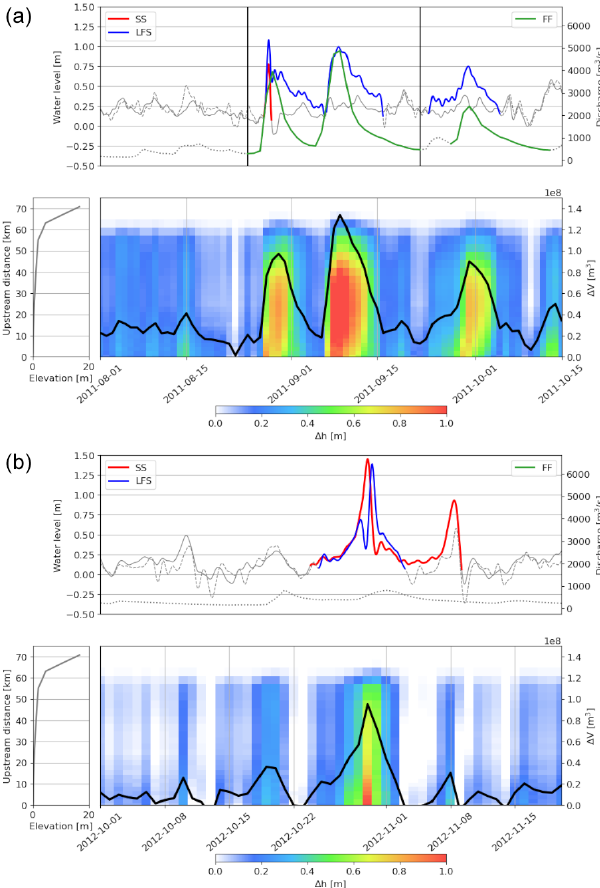
Figure 7. The top panels are the three types of selected extreme events (SS, LFS, FF) overlaid on the corresponding time series of SS, LFS and discharge, represented by solid, dashed and dotted gray lines, respectively, for Hurricane Irene and Tropical Storm Lee (a) and Hurricane Sandy (b) . The compound flood event is marked be- tween the two vertical black lines. The bottom left panels are the riverbed elevation along the backwater propagation extent in the Delaware River and the bottom right panels are (cid:49)h (color shading) along the upstream distance and (cid:49)V (black curve) derived from the MOSART